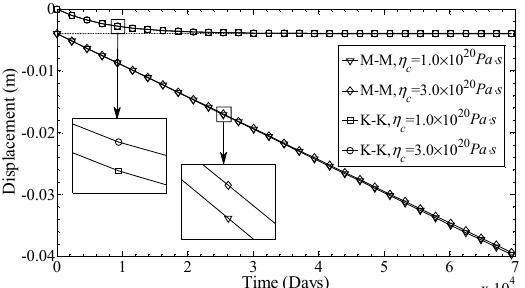
Figure 8. Displacement–time curves obtained from the M–M model and K–K model with different viscosity coefficients of rockbolts.